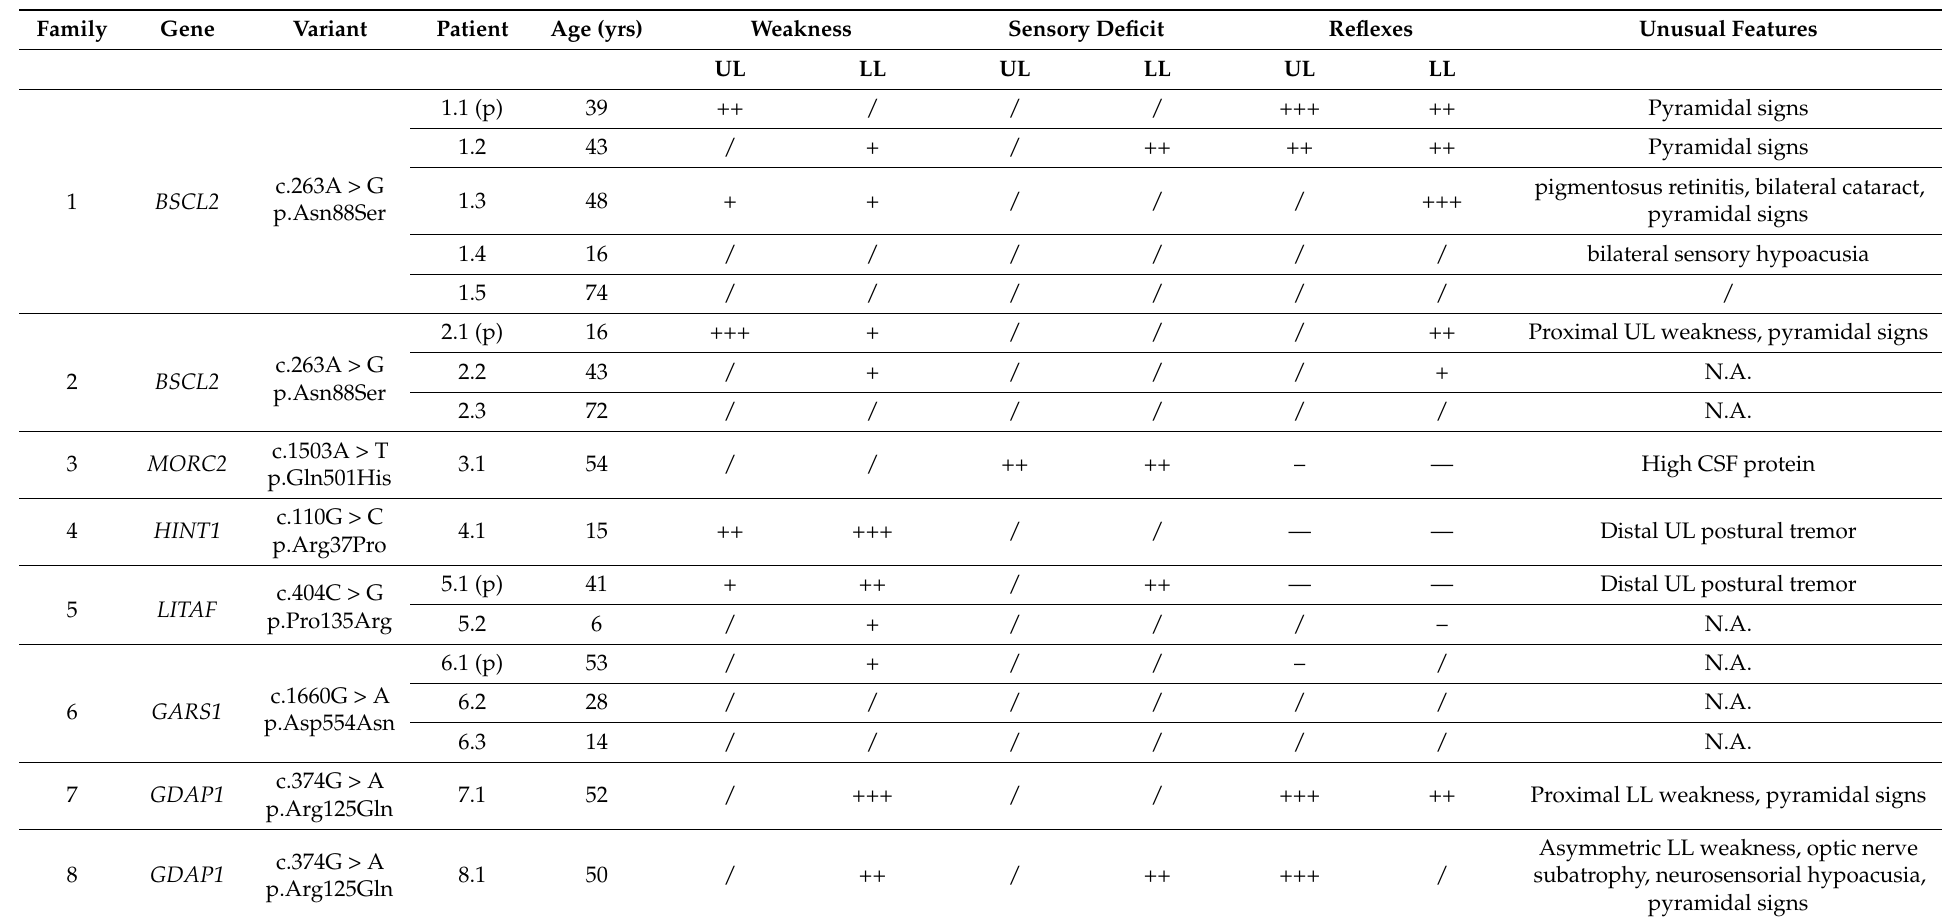
Table 3. Clinical characteristics and unusual features of all of the 17 subjects.